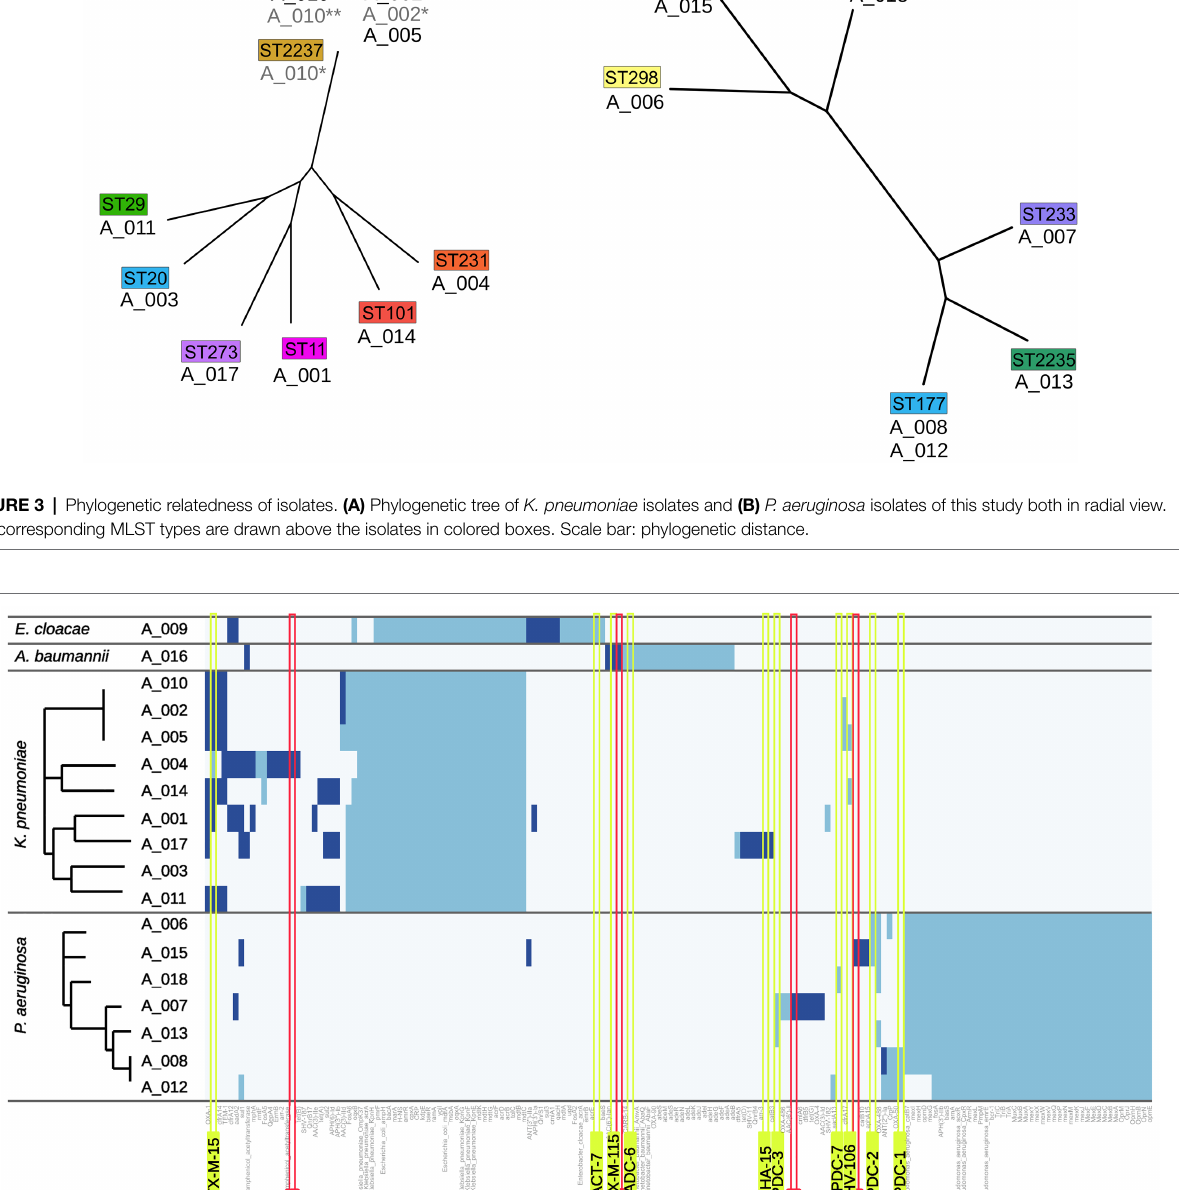
P. aeruginosa isolates. Results highlight that both P. aeruginosa and K. pneumoniae isolates accumulated a variety of unique mutations leading to a frameshift or an insertion of a premature